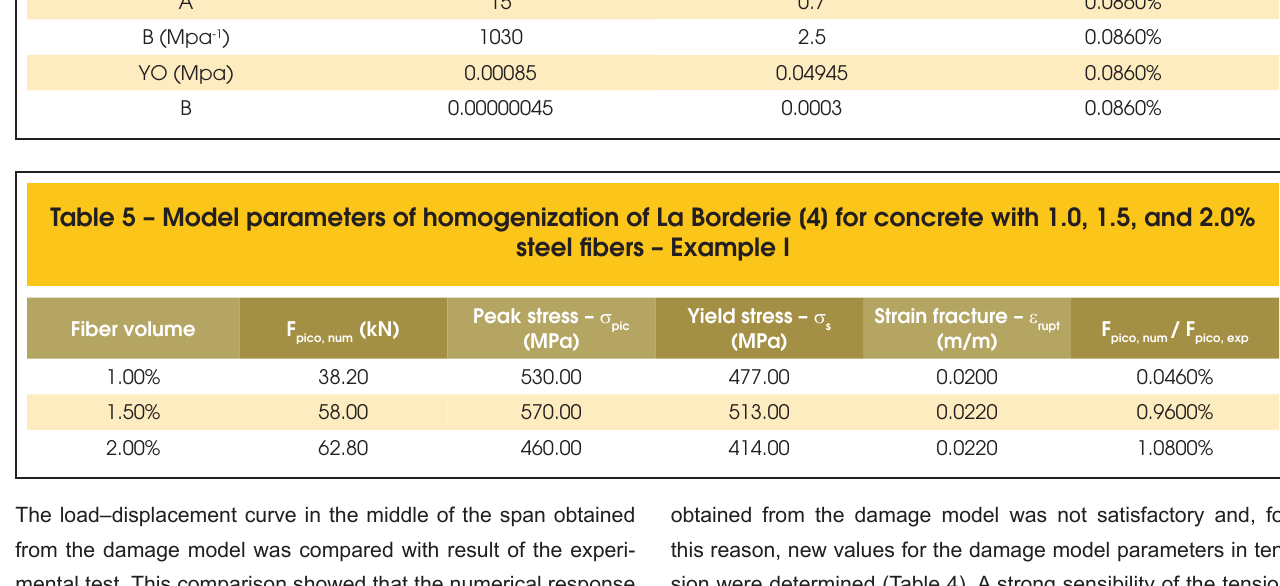
Figure 4 – Comparison of load curve versus displacement in the numerical and experimental middle-span for the four-point flexural test with concrete with 1.0%